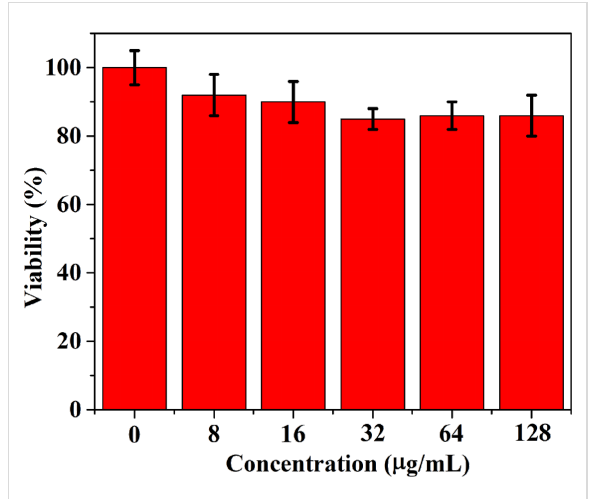
Figure 4: The in vitro cytotoxicity of the Ag–TiO 2 nanocomposites at different concentrations incubated for 24 h with CaCo-2